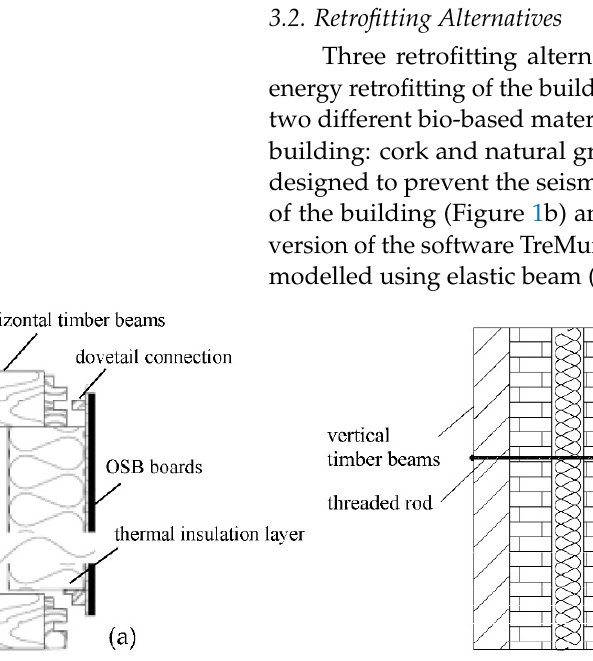
Figure 5. Presentation of the two different variants (Variant 1, Variant 2a) for the seismic retrofitting of the south- east URM facade and the corresponding numerical models that simulate the seismic out-of-plane response of the retrofitted building.